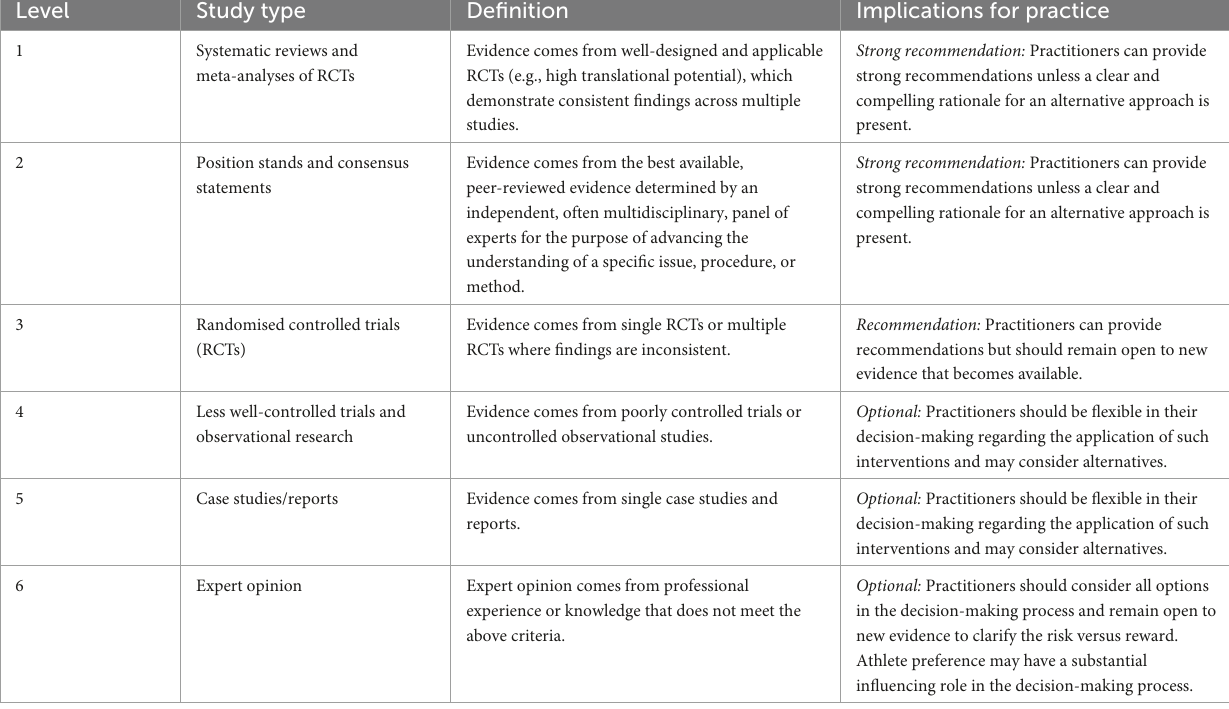
TABLE 2 Levels of evidence for intervention-focused questions and their implications for practice.